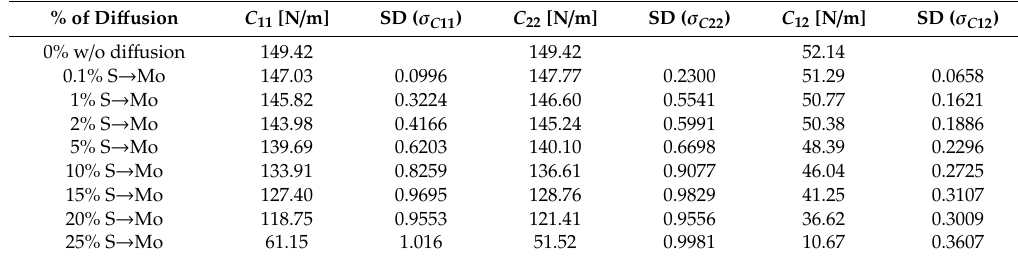
Table 3. The geometry optimized structural parameters for MoS 2 for di ff erent defect fractions of antisite defects along with Standard Deviation